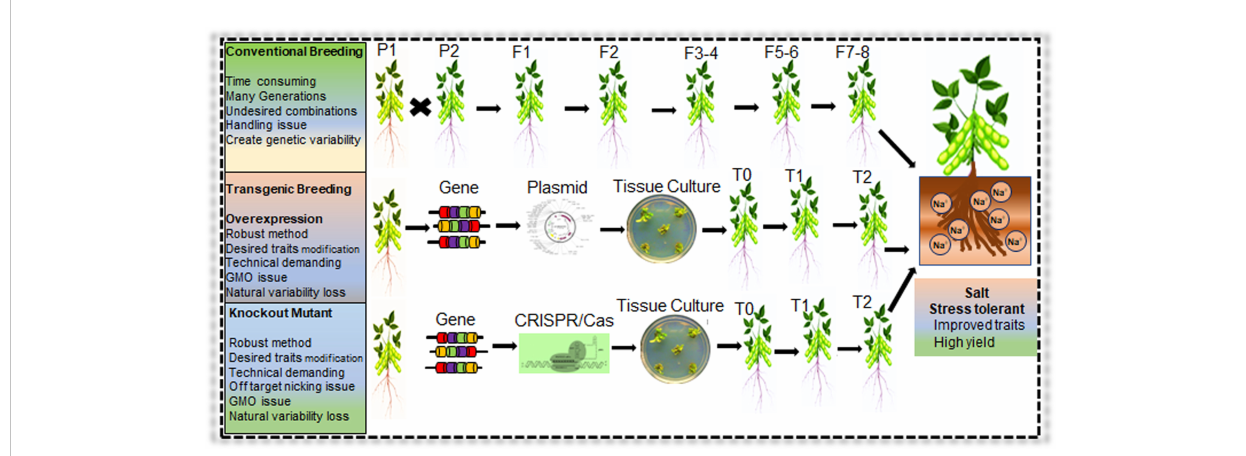
FIGURE 7 Conventional and modern genetic approaches for development of salt stress tolerant Soybean. Application of conventional breeding, transgenic breeding, and genome editing (CRISPR/Cas) system for salt tolerant Soybean germplasm development. Modern biotechnology approaches are robust that can generate stress responsive germplasm in a short duration compared to conventional breeding